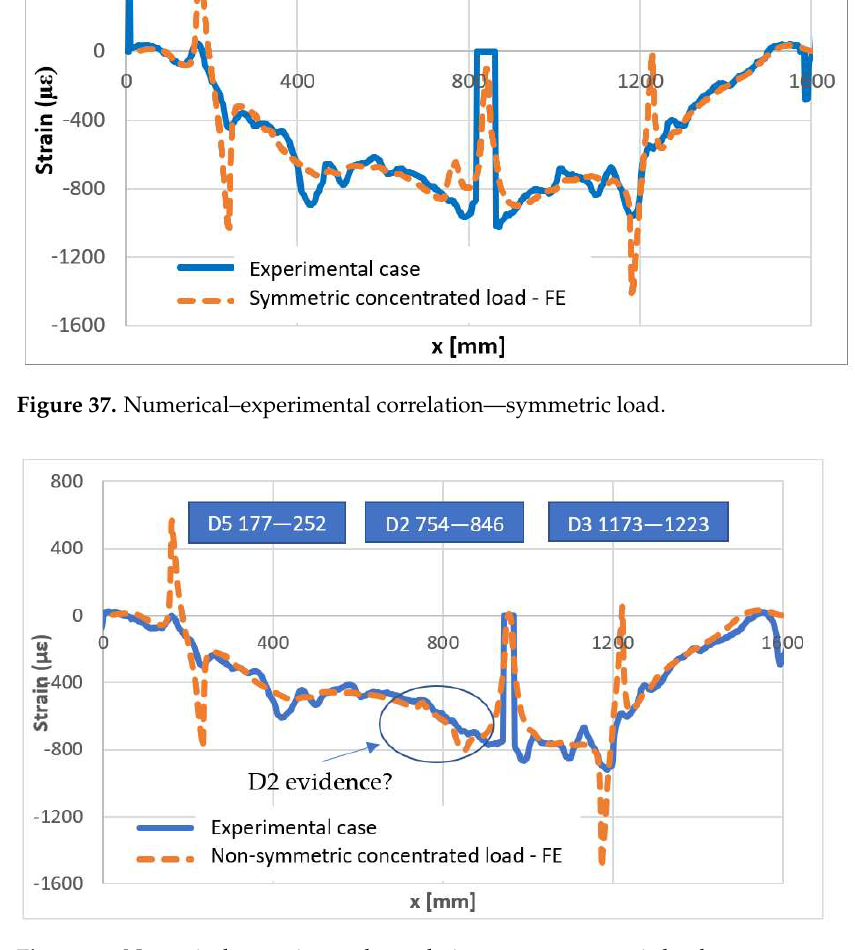
Figure 39. Experimental outcomes for different kinds of non-symmetric load. The measure in mm indicates the spanwise extension of the load, constant in width and covering the entire beam. Load result is always fixed at the same value.